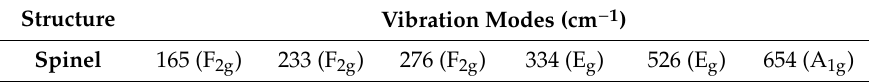
Figure 8. Galvanostatic discharge-charge test at 7 µA cm −2 of a sample treated at 600 °C: ( a ) capacities vs. voltage curves at different cycle number, and ( b ) cycle number vs. capacities curves.